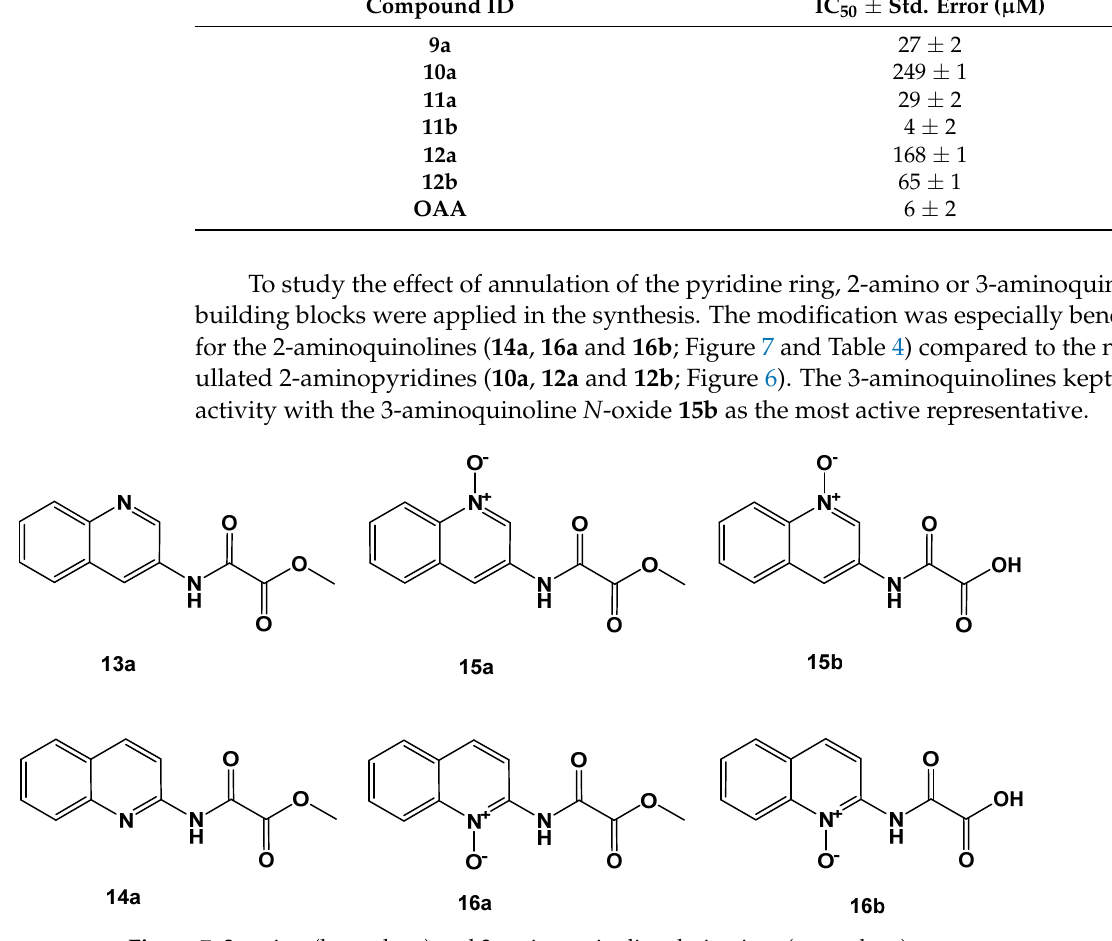
Figure 7. 2-amino-(lower lane) and 3-amino-quinoline derivatives (upper lane). Table 4. N -(quinolin-3-yl)oxalamic acid derivatives 13a , 15a and 15b . N -(quinolin-2-yl)oxalamic acid derivatives 14a , 16a and 16b . R Data fit with GRAPHPAD PRISM 5. Standard error of the fit given in µ M. IC 50 diagrams, including the fit and standard deviations of the individual experiments ( n = 3), are depicted in the Supplementary